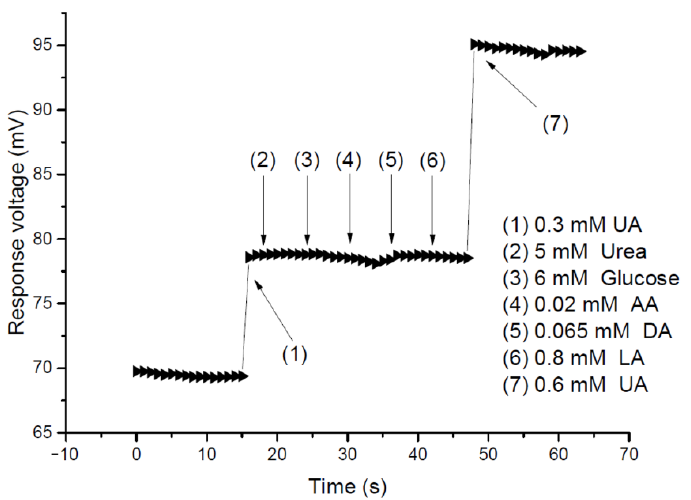
Figure 12. AgNW – uricase/rGO/NiO uric acid biosensor under the presence of the interfering substances. Figure 12. AgNW–uricase/rGO/NiO uric acid biosensor under the presence of the interfering